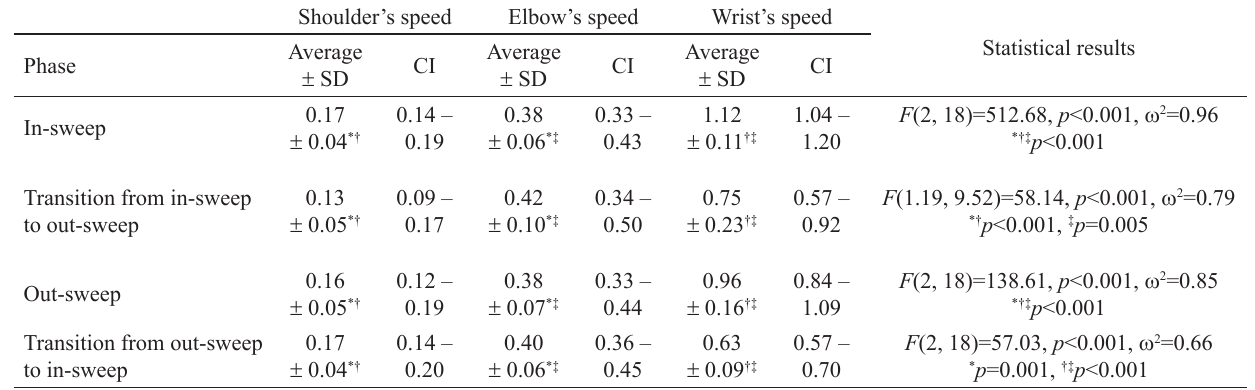
3. Average, standard deviation (SD), lower and upper boundaries of confidence interval (CI) of shoulder, elbow and wrist’s linear speed (m/s) for each phase of the average cycle and statistical results of the comparison between the joints’ speeds in each phase. The same superscript sign indicates differences between joints’ speed in the same phase.